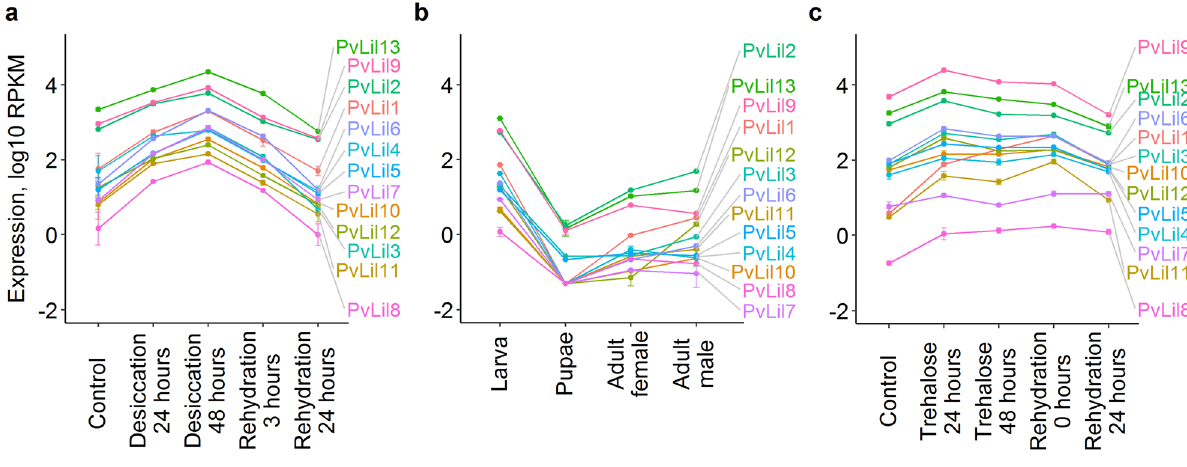
Figure 7. Expression of PvLil genes during P. vanderplanki larvae anhydrobiosis ( a ), at different stages of life cycle of P. vanderplanki ( b ) and during anhydrobiosis of Pv11 cells ( c ). Gene expression data were obtained via mapping of RNA-seq data on a merged assembly consisting of AUGUSTUS-based PvScaf 0.9 assembly with more accurate ARId annotation of ARId regions. Scaffolds in PvScaf 0.9 assembly matching sequences